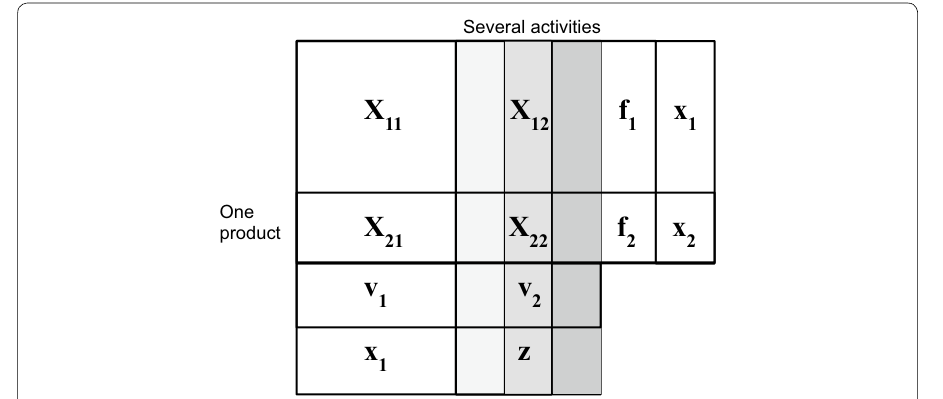
Fig. 2 Input–output table with non-square input transaction matrix Source : Illustrated by